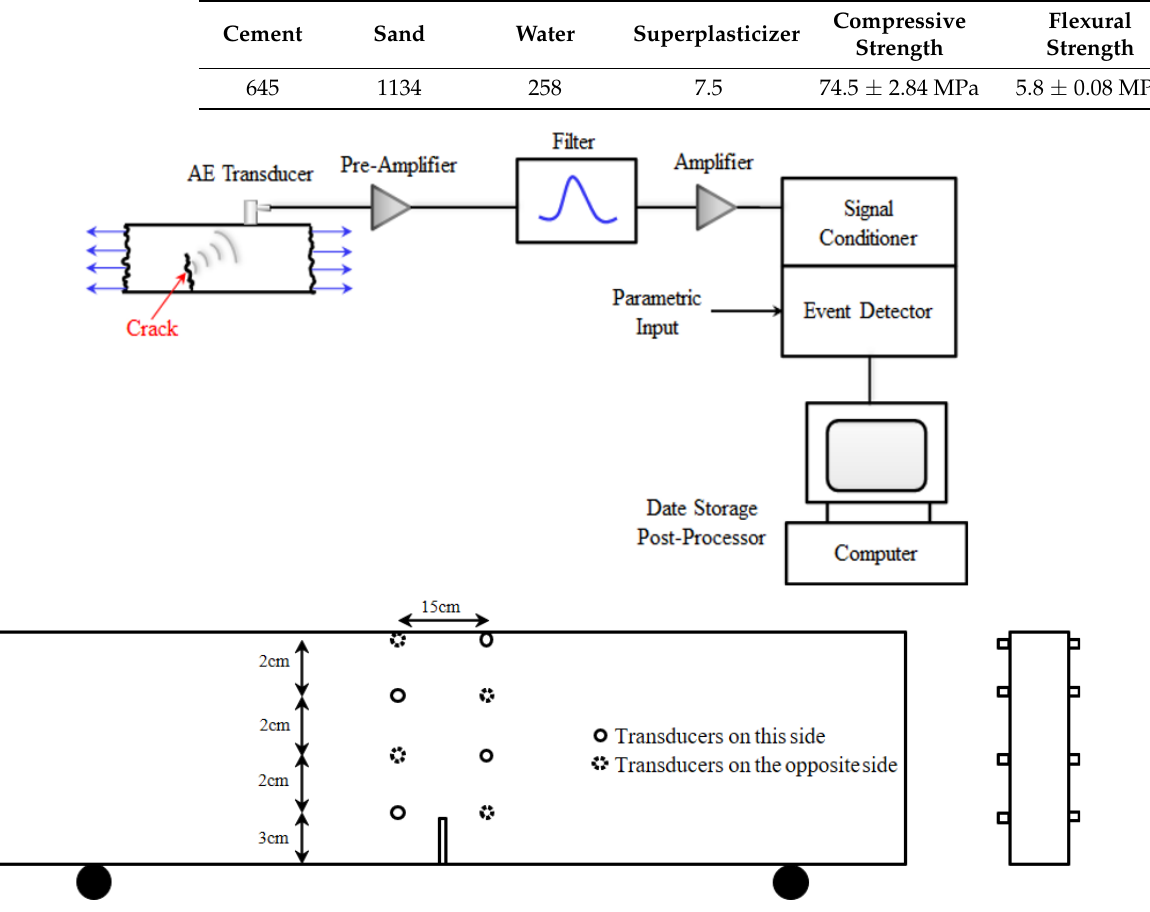
Table 1. Mix design of mortar (kg/m 3 ).